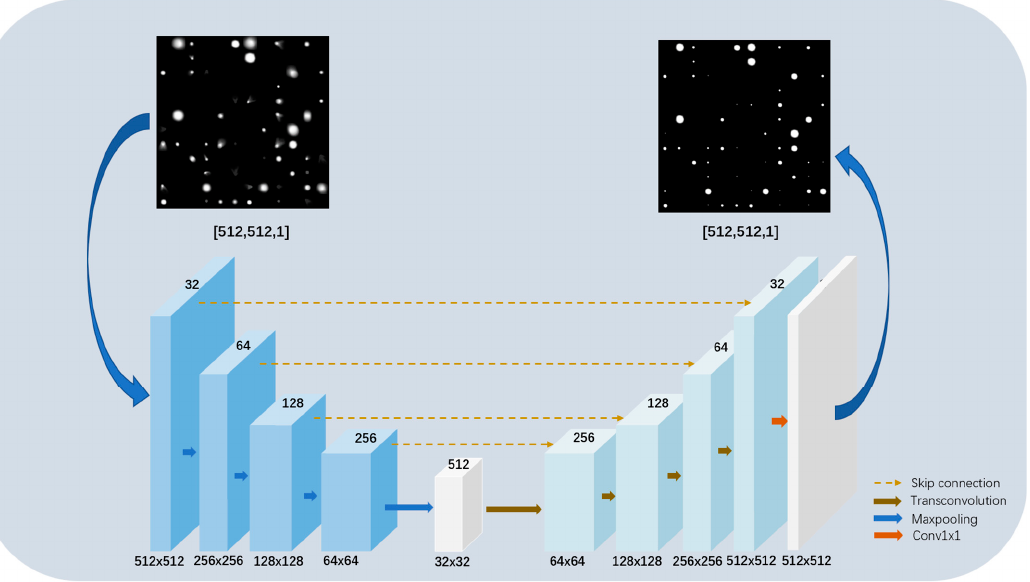
Figure 1. The external main structure of the proposed network. The blue cube on the left represents the encoder structure, and the cyan cube on the right represents the decoder structure. The functional implementation of this network depends on the encoder and decoder, whose internal structure is shown in Figure 2.